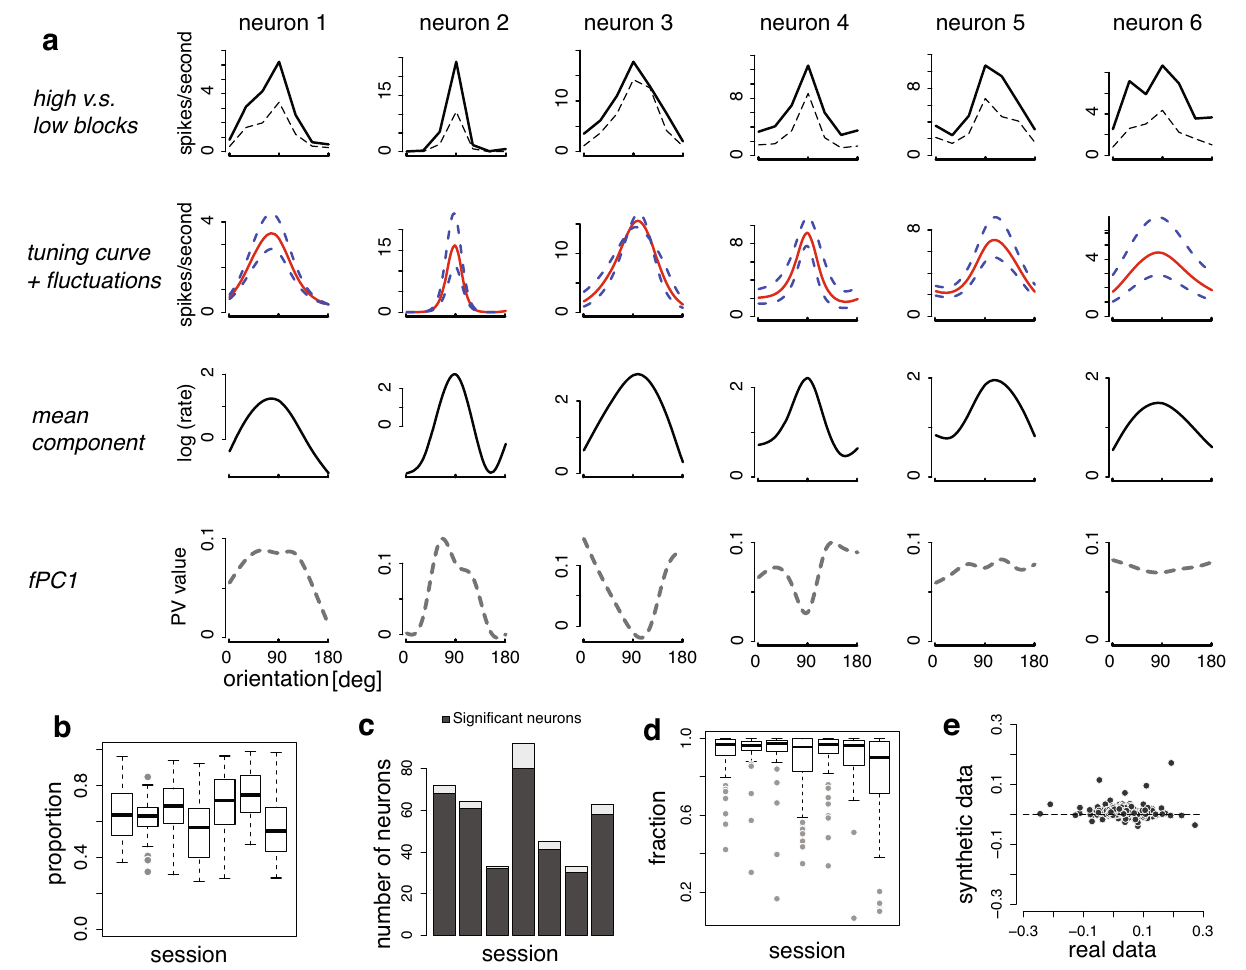
Fig. 3 | Results of Pf-PCA on V1 data. a Recovered mean component and fi rst fPC for six example neurons. Neuronal tuning fl uctuations exhibit a variety of struc- tures.The top panelsshowtheaveragetuningcurvesbysplitting theexperimental blocks into high and low blocks. Panels in the second row show the tuning curves and the fl uctuations inferred from Pf-PCA, plotted in the fi ring rate space. The last tworowsshowthemeancomponentandthe fi rstfPC,bothplottedinthelogarithm ofthe fi ringratescale.Forthelastrow, “ PV ” (y-axis)representsthevalueofthe fi rst fPC for each stimulus. b The variance explained by the fi rst fPC. Central mark: medianvalue.Edgesofthebox:25thand75percentiles.Whiskers:themaximaand minimaofthedatawithin1.5timestheinterquartilerangefromthenearestquartile.